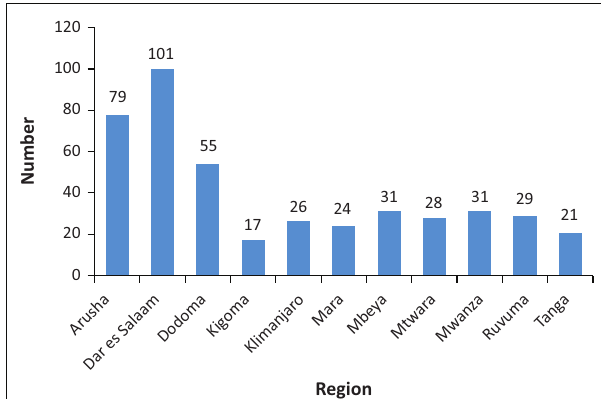
FIGURE 5: Distribution of users per